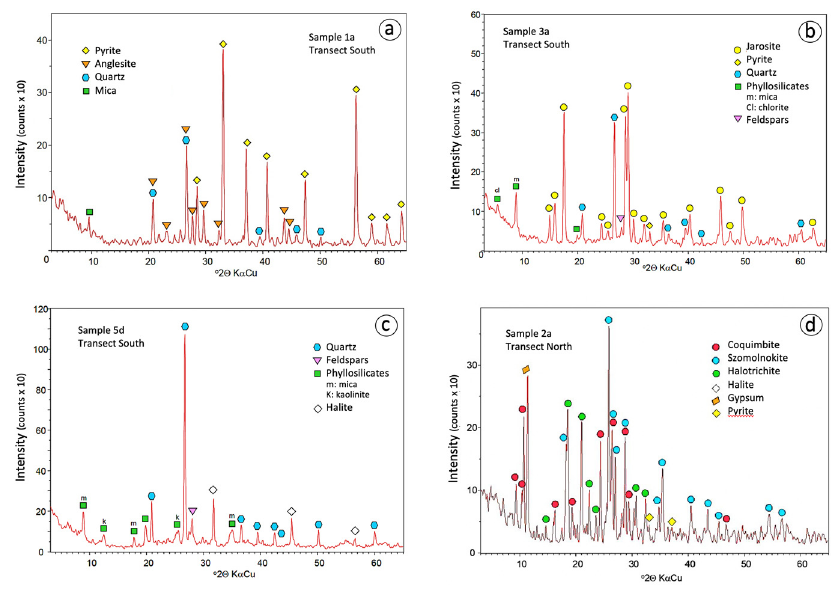
Figure 4. Powder XRD diffractograms of representative samples of the sulphide wasteland ( a ), yellow zone ( b ), ochre zone ( c ), and sulphate crusts ( d ).